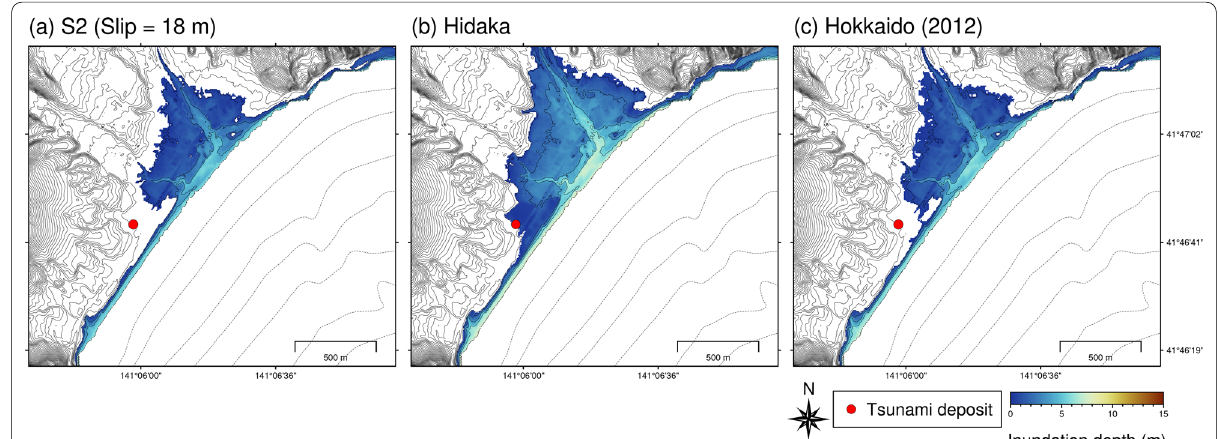
Fig. 9 Computed inundation area in Takadai using the S2, Hidaka (base), Hokkaido (2012) models. The red circle shows the tsunami deposit location found by Kase et al. (2022). The solid contour shows the topography, and the dotted contour shows the bathymetry (less than 0 m). The land contour interval is 2 m, and the sea contour interval is 5